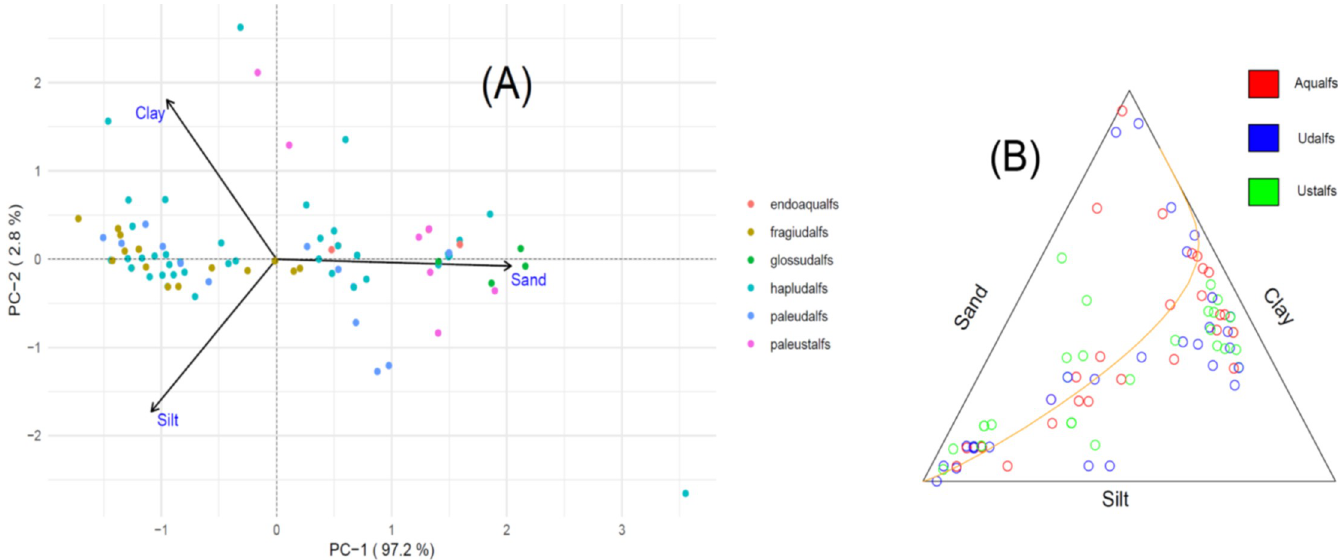
Fig 4. Statistical plots for the PSD composition grouped according to Great Group designation. (A) Clr-transformed biplot for the full PSD composition. (B) t-PCA plot for the full PSD composition, with the orange line in the t-PCA plot representing the principal axis.